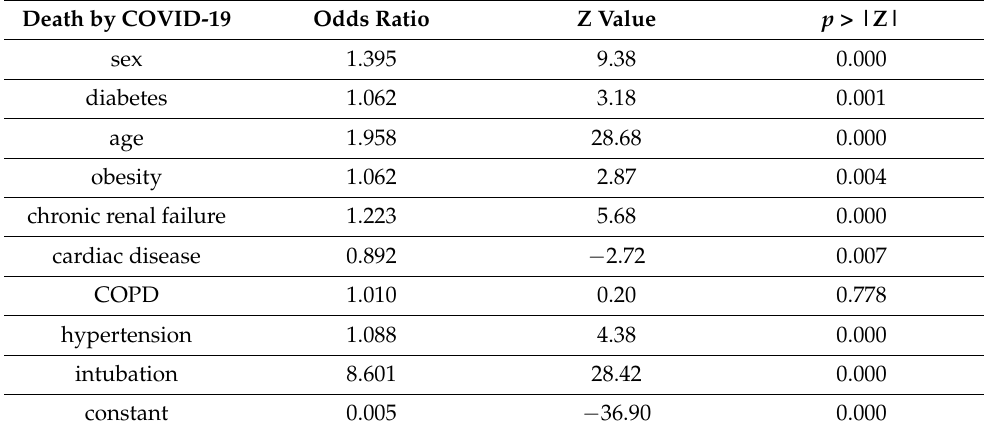
Table 2. Logistic regression test with death as dependent variable and main factors as covariates. Death by COVID-19 Odds Ratio Z Value p > |Z| sex 1.395 diabetes obesity chronic renal failure